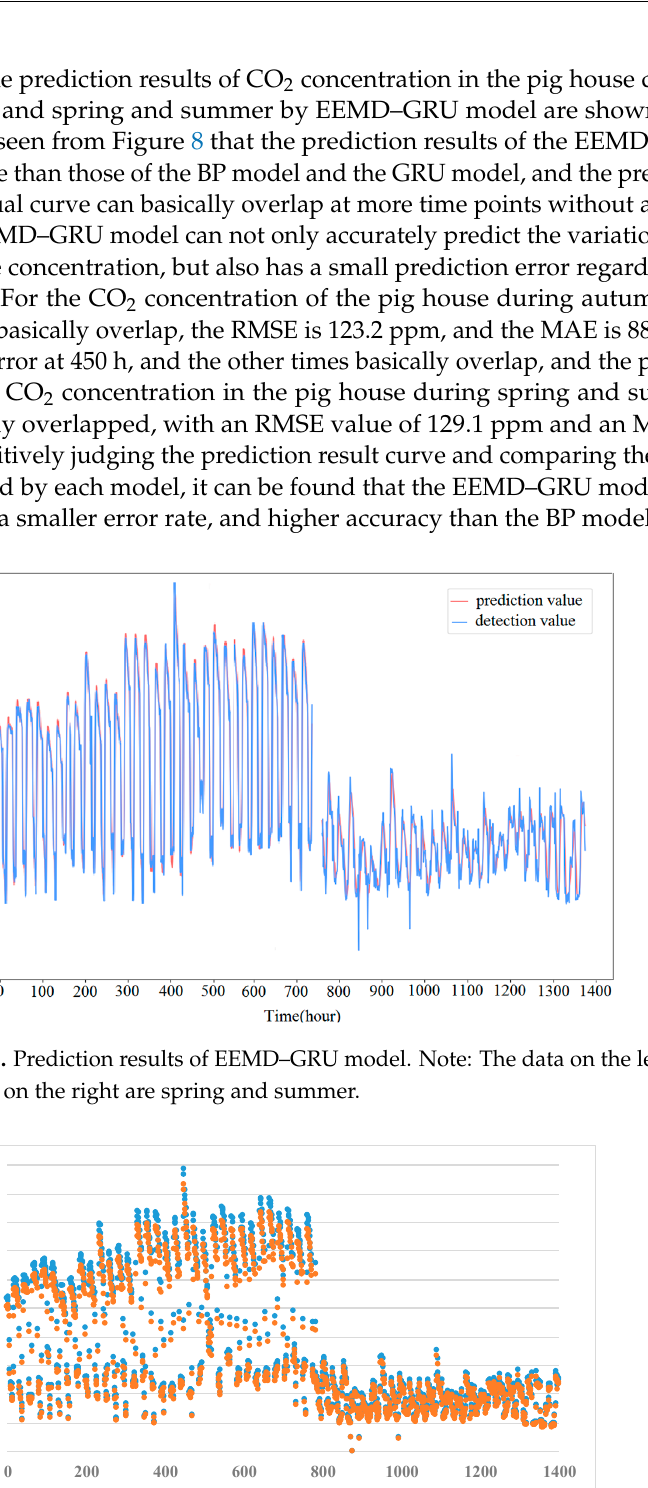
Table 5. Comparison of prediction errors of the three models. Season